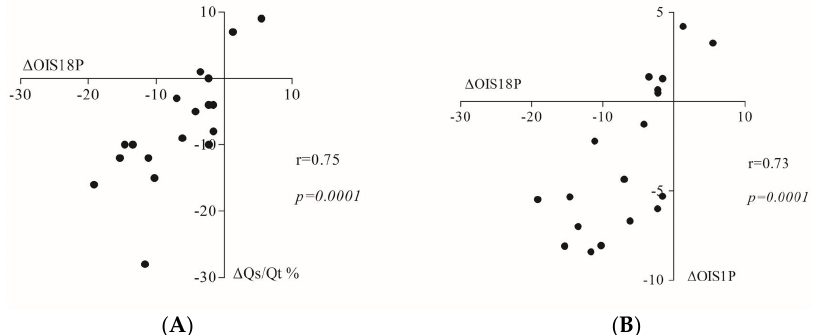
Figure 1. Pearson’s correlation coefficient r and p -value ( p ) between: ( A ) the change in the Oxygena- tion Index from baseline semi recumbent (SR BAS ) to 18 h prone ( ∆ OI S18hP ) and the respective change in shunt fraction ( ∆